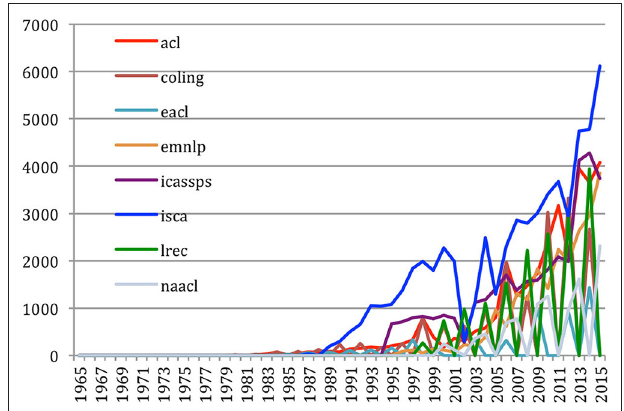
FIGURE 38 | Number of references in papers over the years for the eight most important conferences.